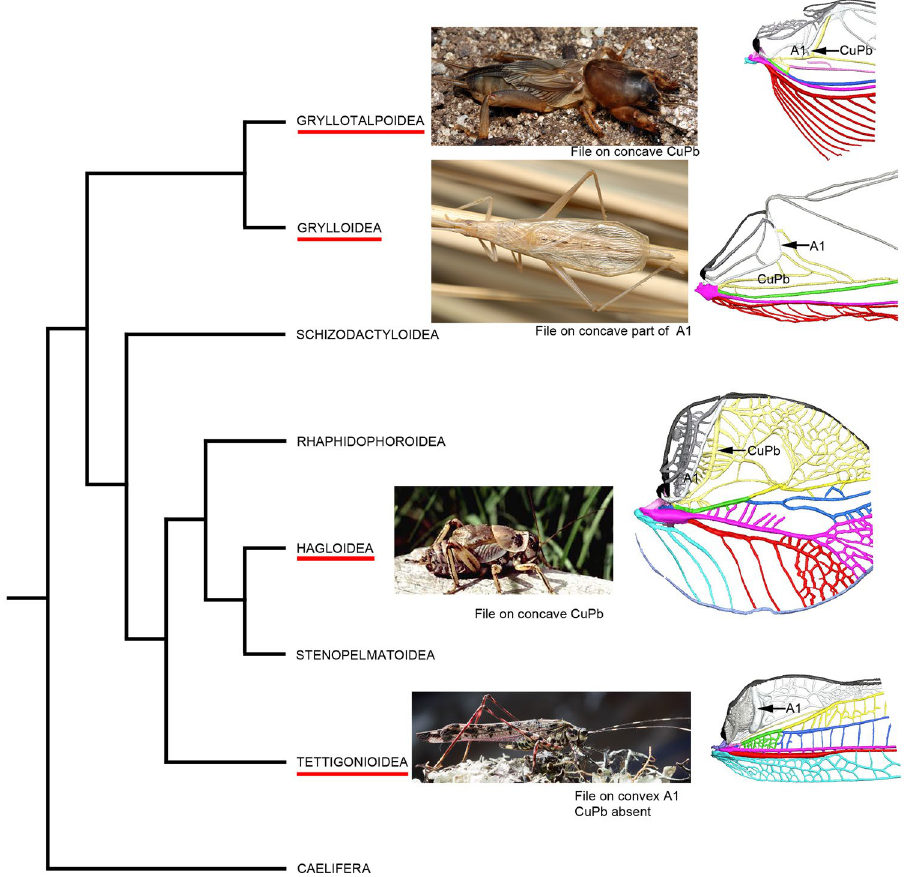
Figure 4. Molecular phylogeny of Ensifera (after Song et al . 12 ). The four singing groups are indicated by photographs of representatives and the reconstructions of the cubito-anal fields (arrows indicate the files) (copyrights of photographs S. Hugel, D. Gwynne, P.S. Padron).